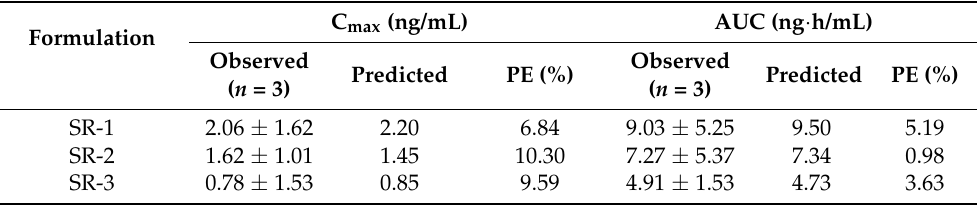
Figure 7. A comparison of the final extended DoE-IVIVC model-predicted and observed plasma concentration vs. time profiles following the oral administration of SR-1 ( A ), SR-2 ( B ), and SR-3 ( C ) donepezil SR tablets in Beagle dogs. Table 5. The absolute percentages of the prediction error (PE) for C max and AUC of SR-1, SR-2, and SR-3 by the extended DoE-IVIVC model.